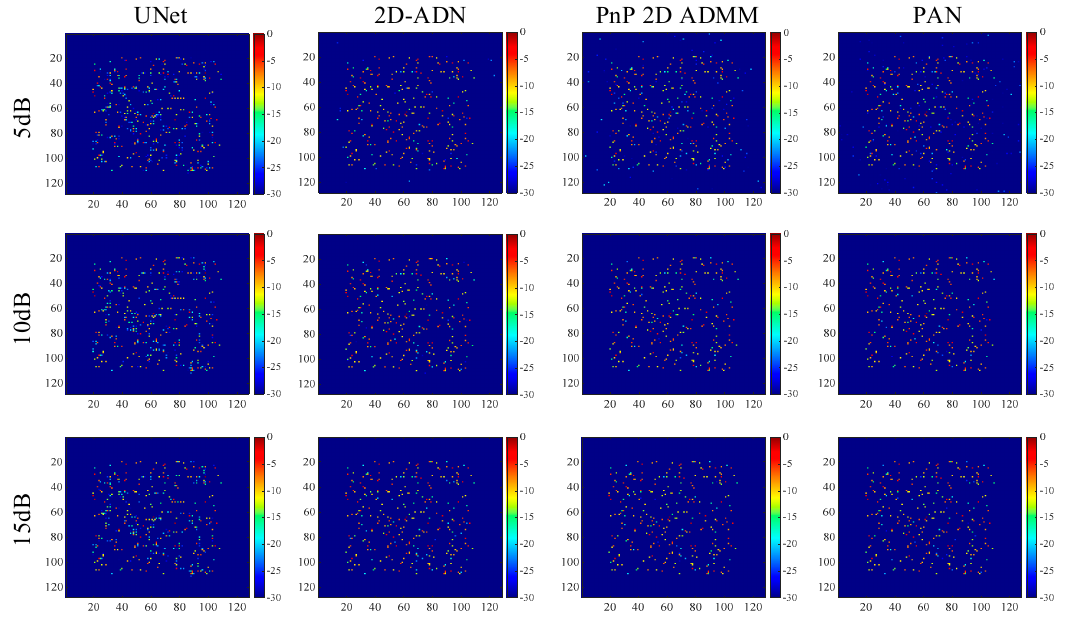
Figure 4. ISAR images of Figure 3b with different SNR. Table 2. Performance evaluation for the simulated 2D incomplete data under 10 dB condition. Table 1. Performance evaluation for the simulated 2D incomplete data under 5 dB condition.